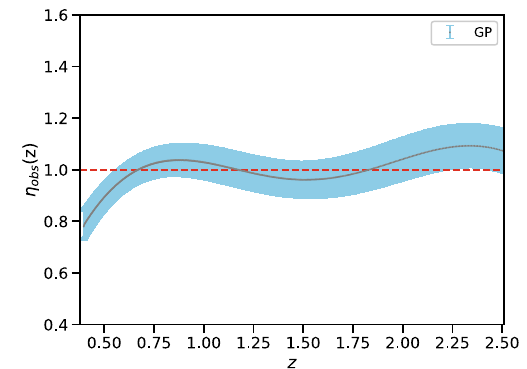
Fig. 4 The posterior probability density function with three parame- terized forms η j ( j = 0 , 1 , 2) by using GP reconstructed HII galaxy and compact radio quasar